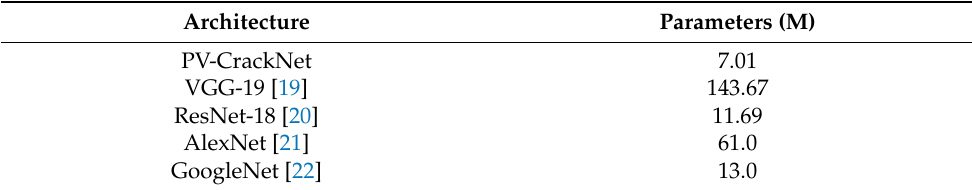
Table 5. Computational comparison.